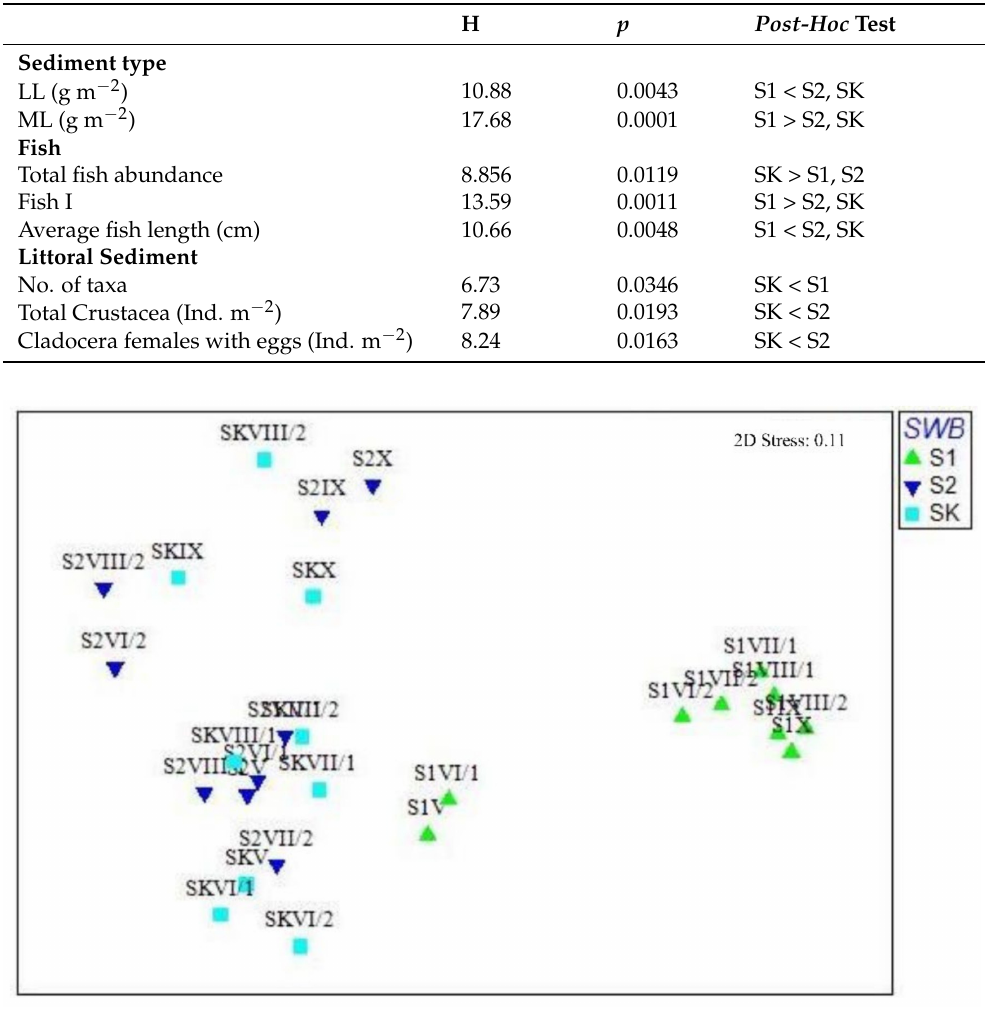
Figure 3. Non-metric multidimensional scaling (NMDS) ordination based on fish traits, sediment type, and macrophyte coverage in three SWB based on Euclidian